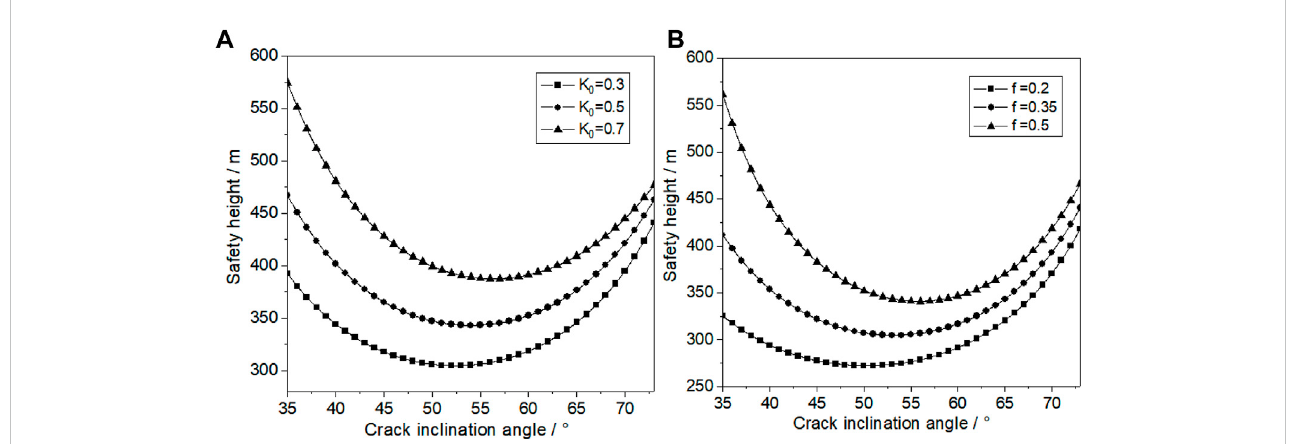
FIGURE 8 Variationintheslopesafetyheightwiththecrackdipangle: (A) in fl uenceoftheside-pressurecoef fi cientand (B) in fl uenceoftheside-frictioncoef fi cient.